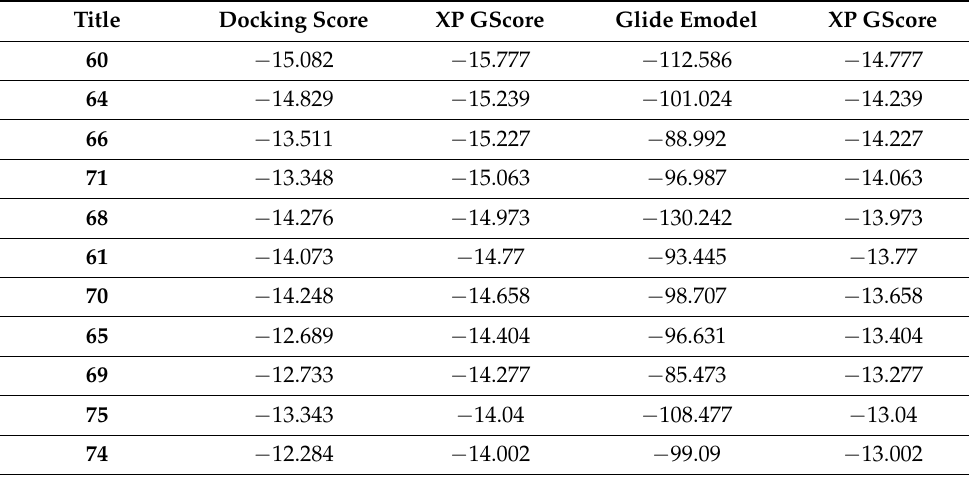
Figure 15. Docking validation by the re-docking of the native inhibitor into GLUT1 (PDB ID: 5EQG). ( A ) The interaction between the crystal structure 5EQG and the reference inhibitor 5RE in 2D view. ( B ) The binding interactions in 3D view, and ( C ) 3D interaction with mesh surface view. After validating the docking method, the 3D structures of the minimized phenalenone derivatives were docked into GLUT1. The docking results are presented in Table 5, which shows that, except for derivative 118 , all phenalenones scored higher than the native inhibitor ( − 11.206 kcal/mol). Derivatives 60 and 64 were on the top of the list, scoring − 15.777 and − 15.239 kcal/mol, respectively. Table 5. The in silico docking results of phenalenone derivatives with GLUT1 (PDB: 5EQG